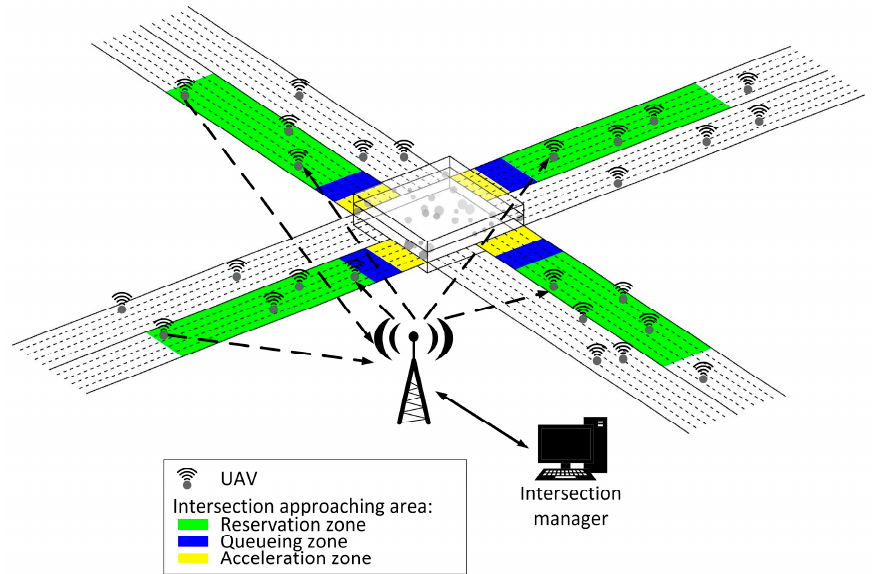
Figure 1. 3D intersection model.